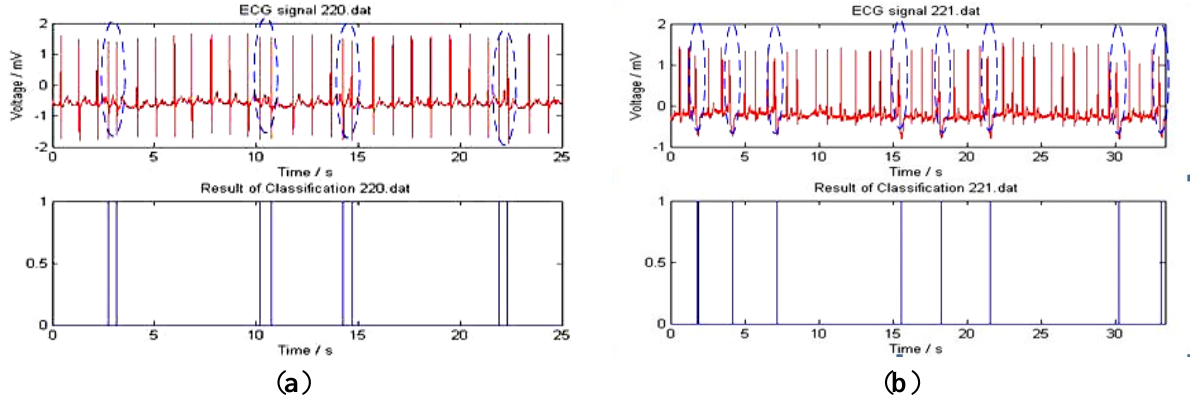
Figure 15. ECG classification